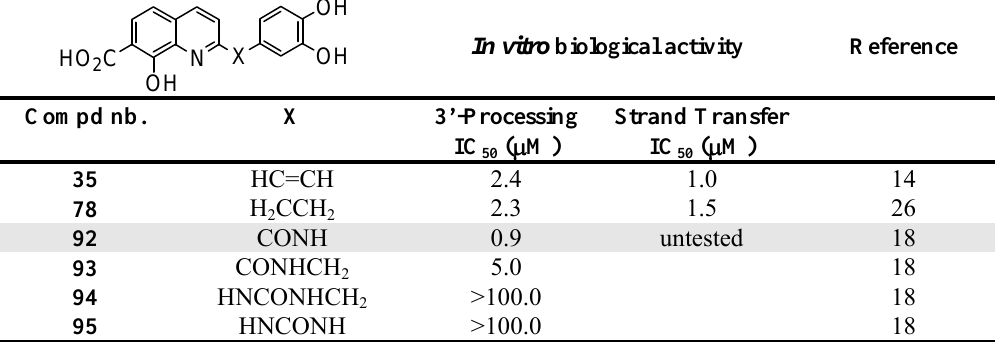
Table 8. HIV-1 IN inhibitory potency of spacer modified inhibitors.